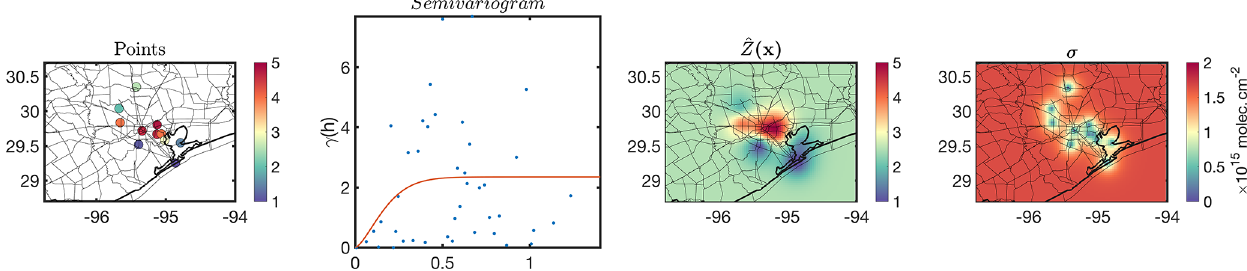
Figure 13. The Pandora tropospheric NO 2 measurements (made from subtracting the total columns from the OMI stratospheric NO 2 columns) during September 2013, the corresponding semivariogram, the kriging estimates, and the kriging standard errors. Note that the semivariogram suggests a large degree of spatial heterogeneity occurring at different spatial scales.